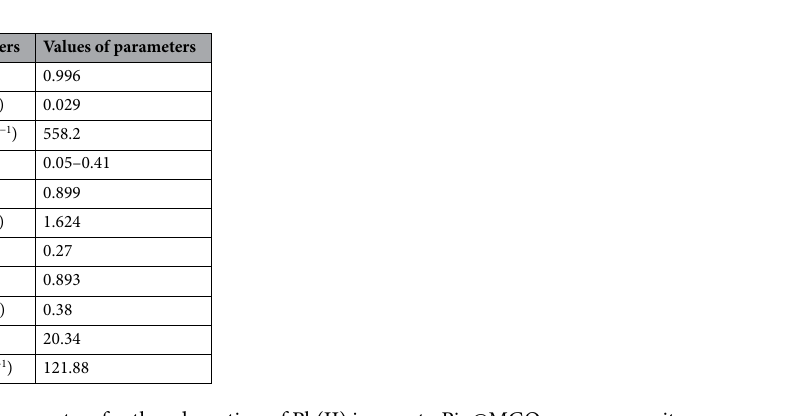
Table 3. Isotherm parameters for the adsorption of Pb(II) ions onto Pip@MGO nanocomposite.